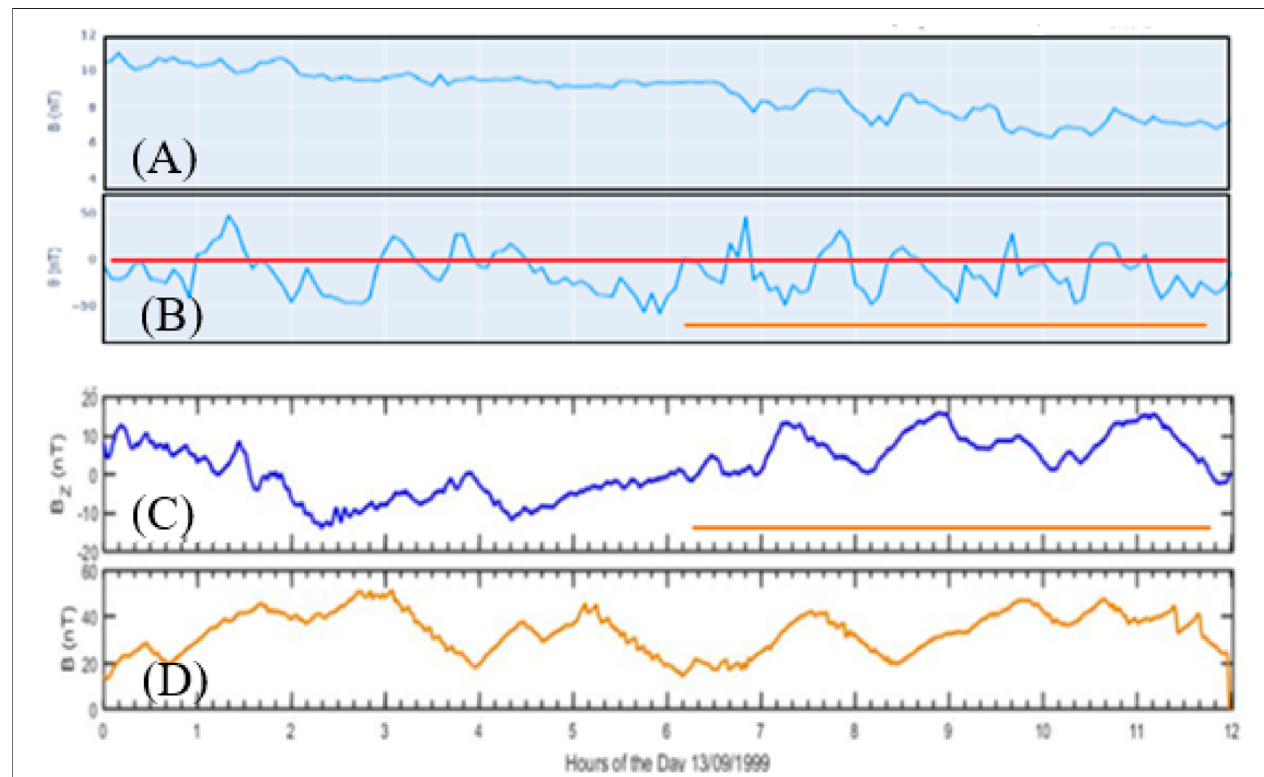
FIGURE5| Thesub-ULFBwaveactivityinTaiwan (C) changesafter ∼ 7UTfollowingachangeintheMHDAlfvénwavepatternatACEsatellite,intheinterplanetary space (A, B) .